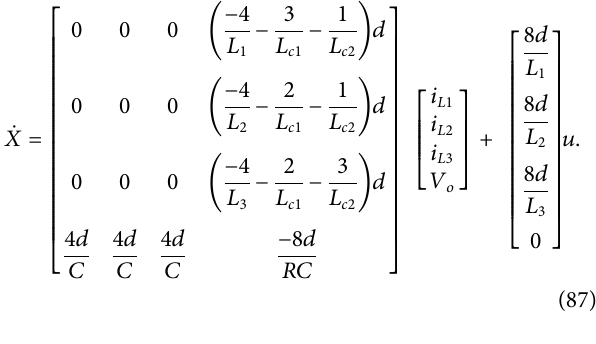
Frontiers in Energy Research |